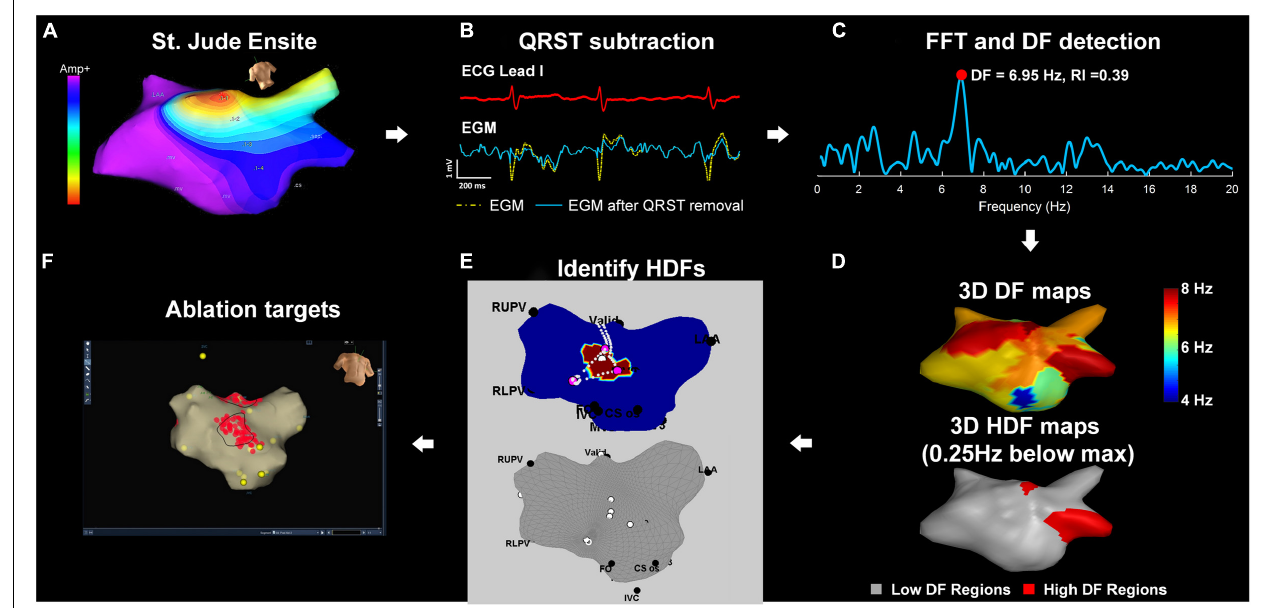
FIGURE 1 | Diagram of the workflow for ablation targets identification. (A) St. Jude Ensite: left atrial geometry isopotential map exported from Ensite Velocity System. (B) Array data is imported into a bespoke MATLAB user interface. QRST subtraction: Electrograms using one ECG lead as reference. (C) FFT and DF detection: power spectrum of the current non-contact atrial signal and DF identification (D) 3D and 2D DF/HDF maps: MATLAB reconstructed 3D Atrial geometry with color-coded DF/HDF and transformation to 2D uniform grid. (E) The top panel shows an antero-posterior view of the LA, with the region hosting HDF for a single 4 s time window highlighted in purple. The pink dots indicate the HDF spatial centers for all time windows. For better intraprocedural clarity, the bottom panel shows only the HDF spatial centers (white dots) identified across all the mapped time windows. (F) Identifying and ablating HDF regions. These are transcribed into the Velocity 3D mapping system and targeted with ablation (red dots). Yellow dots represent anatomical marker points. FFT, fast Fourier transform; HDF, highest dominant